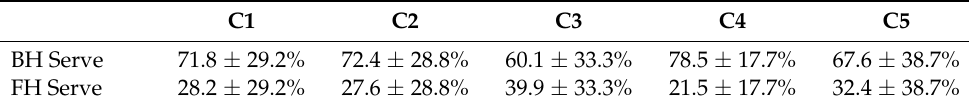
Table 6. Distribution of backhand and forehand serve executions for each class (mean ± SD).